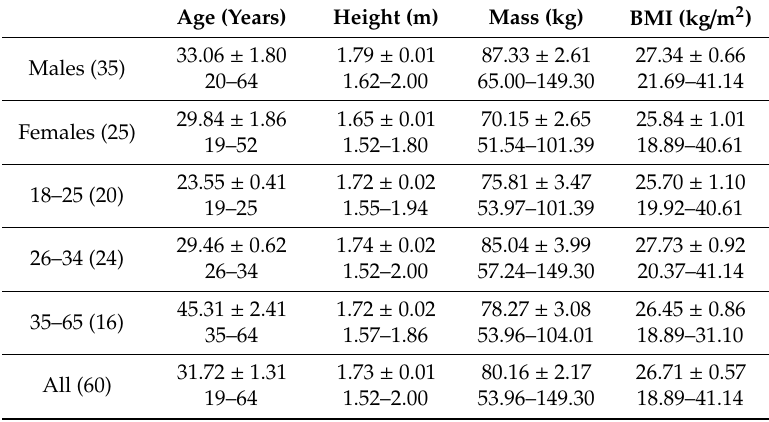
Table 1. Demographics and anthropometric characteristics for all the included healthy controls (number of subjects, mean ± SEM and range). Values are grouped by sex and the breakdown between the three age groups is also included.